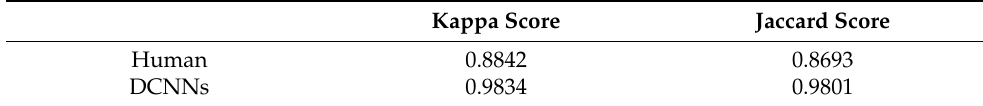
Table 5. Overall performance of the multiclassification task.